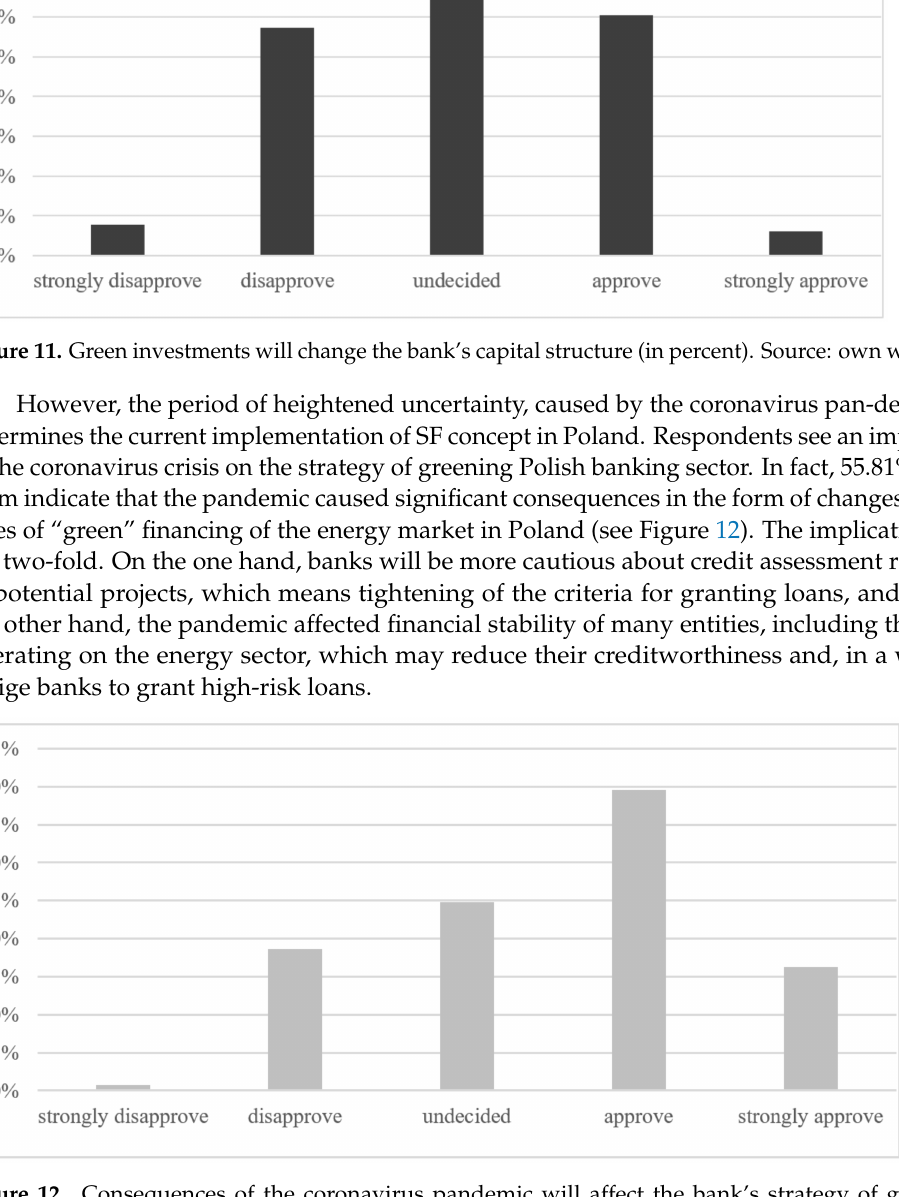
Figure 12. Consequences of the coronavirus pandemic will affect the bank’s strategy of green financing (in percent). Source: own